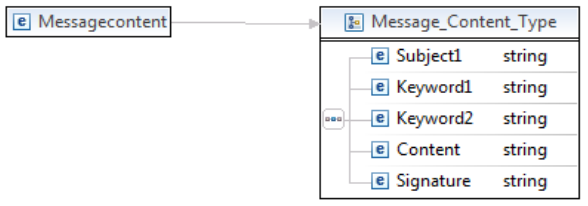
Figure 9. Generic structure of business object